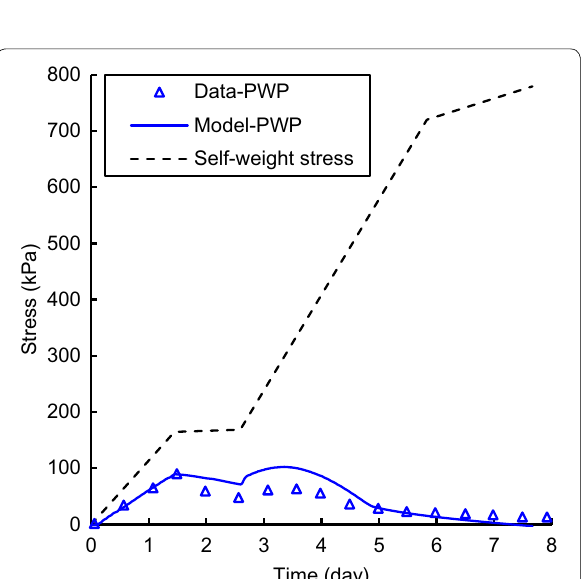
Fig. 8 Comparison of predicted results and measured values of PWP at Kanowna Belle